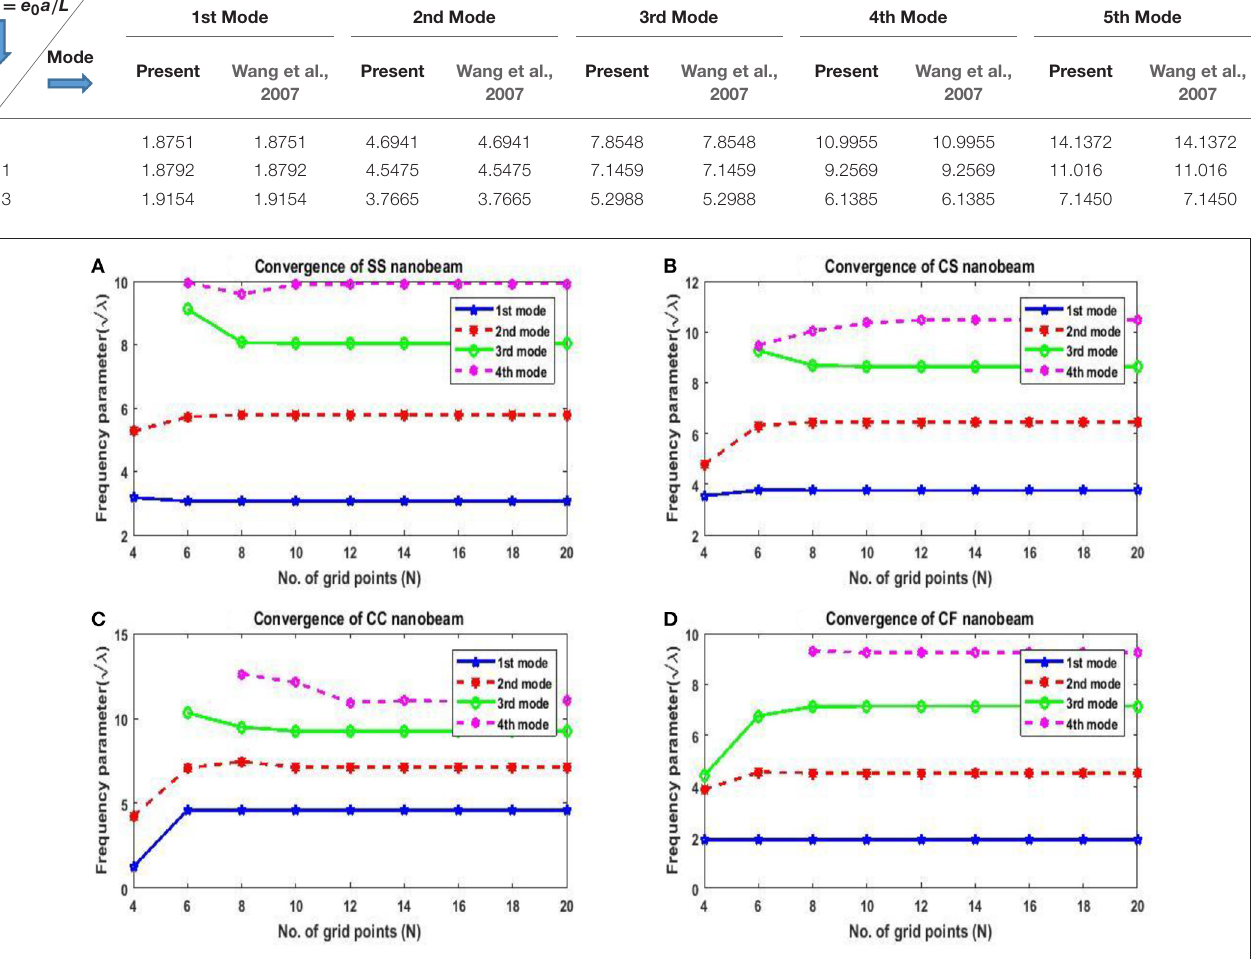
TABLE 6 | Comparisons of frequency parameter α = e 0 a / L